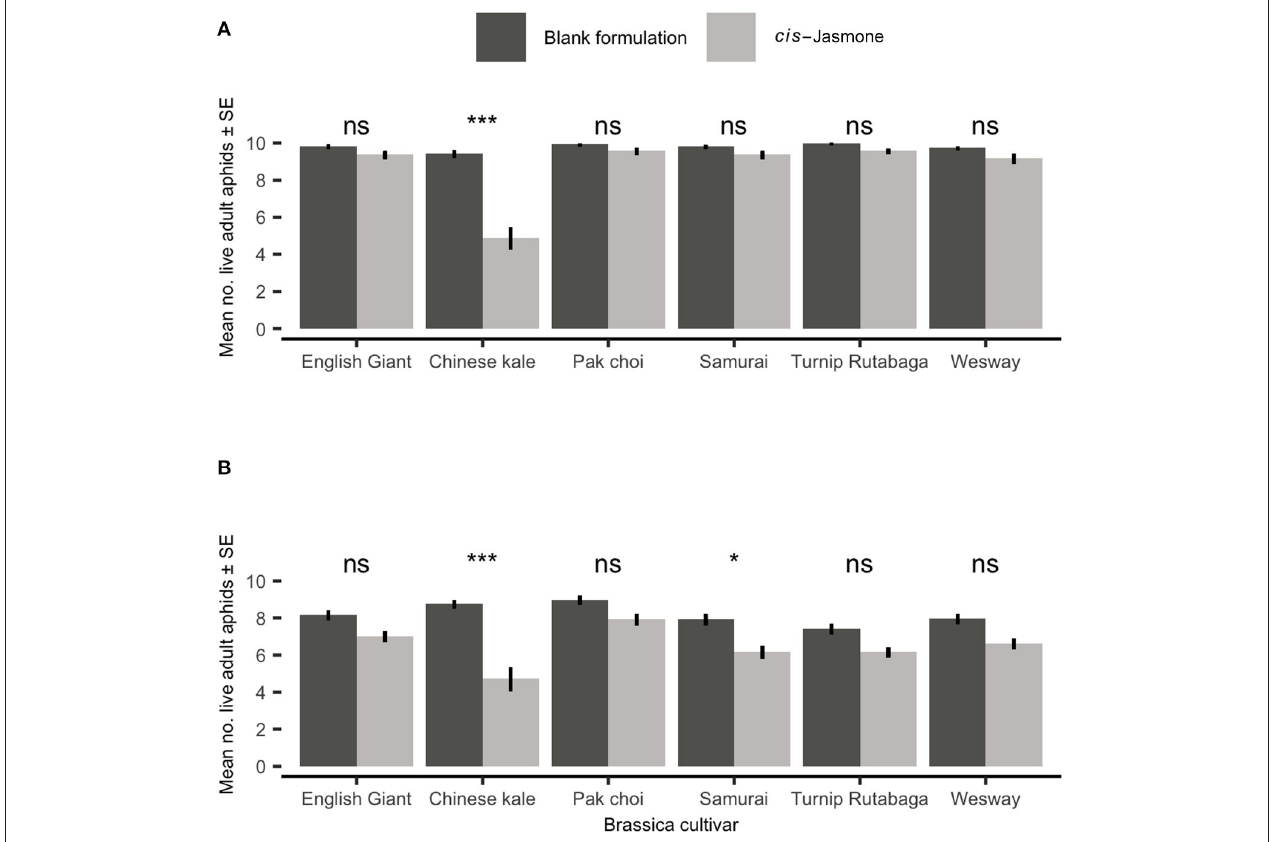
FIGURE 1 | Adult Myzus persicae survival (Mean ± SE) out of the original 10 individuals after (A) 48h and (B) 96h in clip cages on six brassica cultivars ( n = 10) treated with cis- jasmone or blank formulation (control). Brassica cultivars capped with “ns” do not show a significant difference between control and cis -jasmone treatment while asterisks denote differing levels of statistical significance: * < 0.05 and *** < 0.001 (generalised linear models with Poisson probability